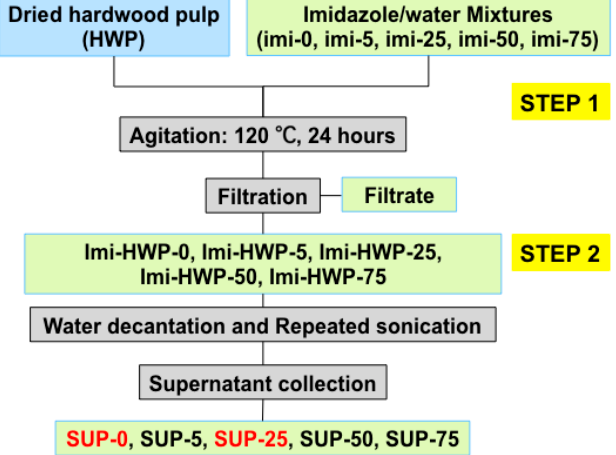
Figure 1. Two-step treatment of hardwood pulp in imidazole/water mixtures.